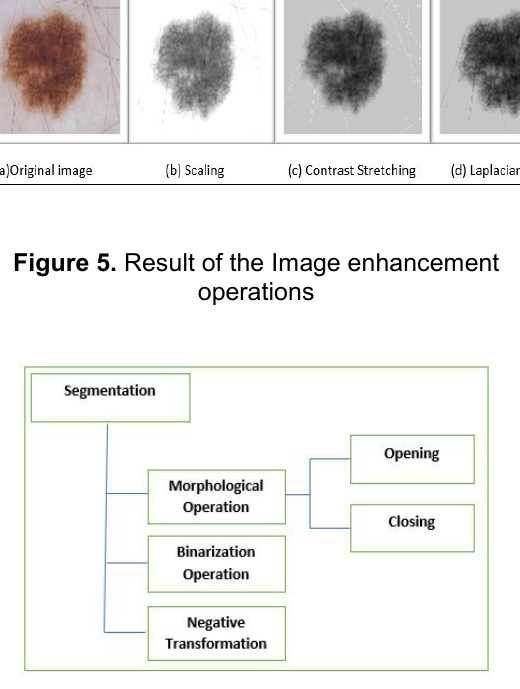
Figure 6. Proposed Segmentation Techniques